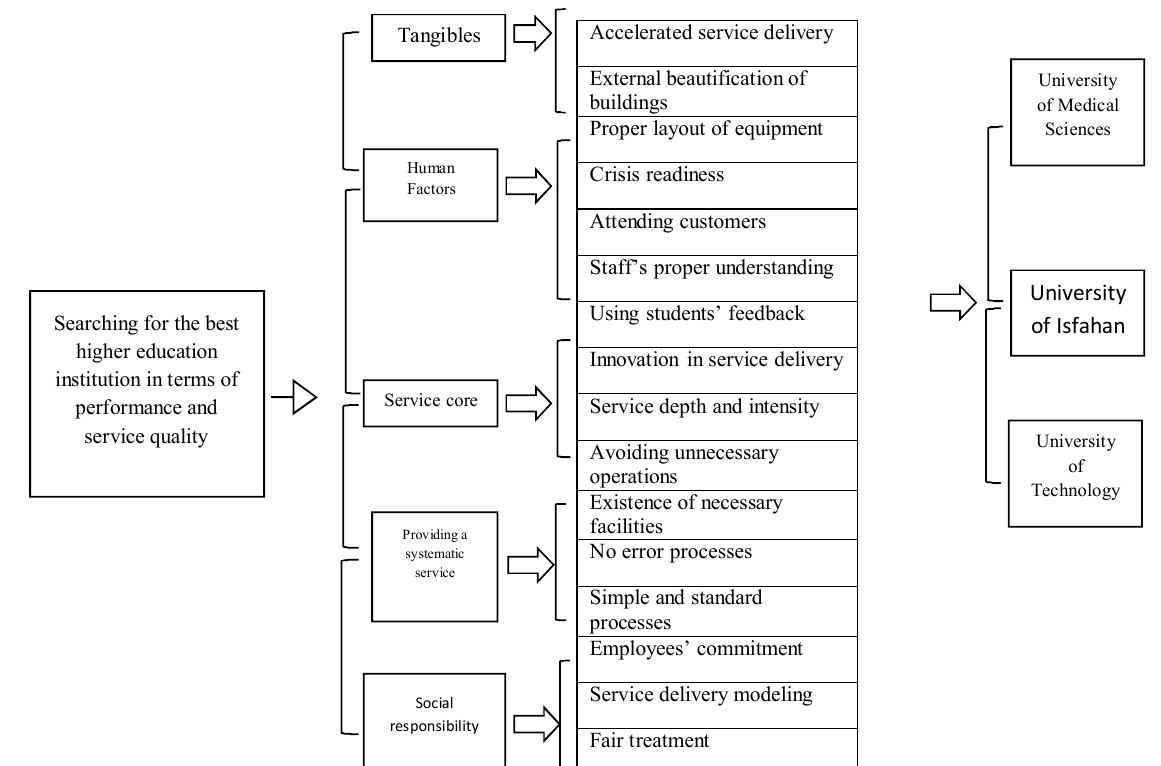
Fig. 2. Hierarchy of service quality assessment based on SERVQUAL